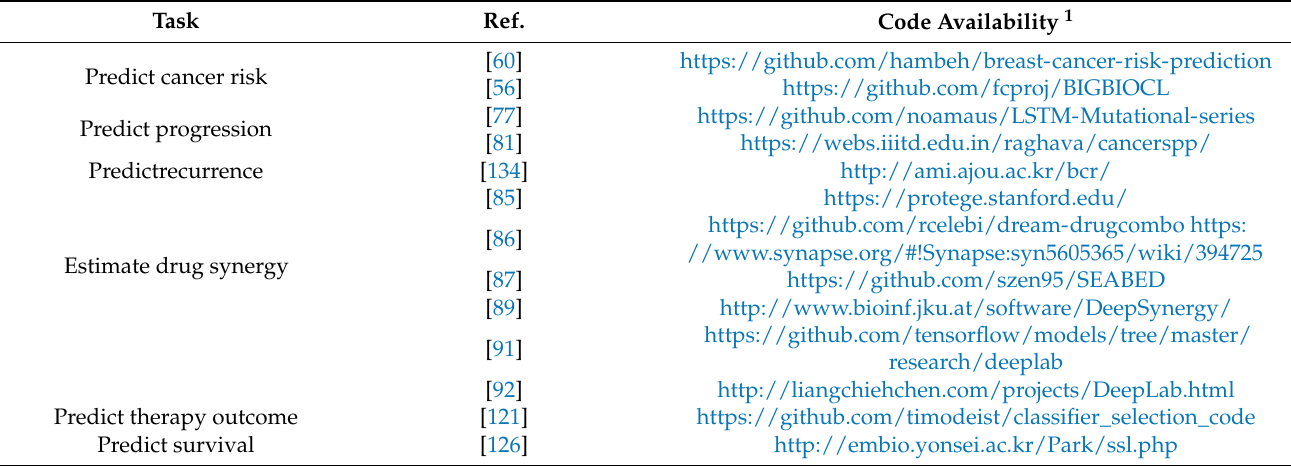
Table 7. List of code repositories or servers listed in the manuscript.